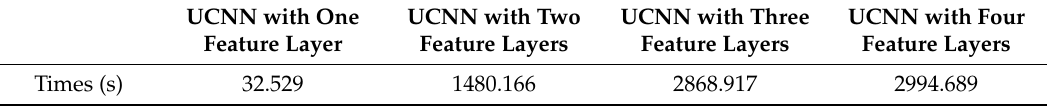
Table 9. Training time of the proposed unsupervised feature learning neural networks.